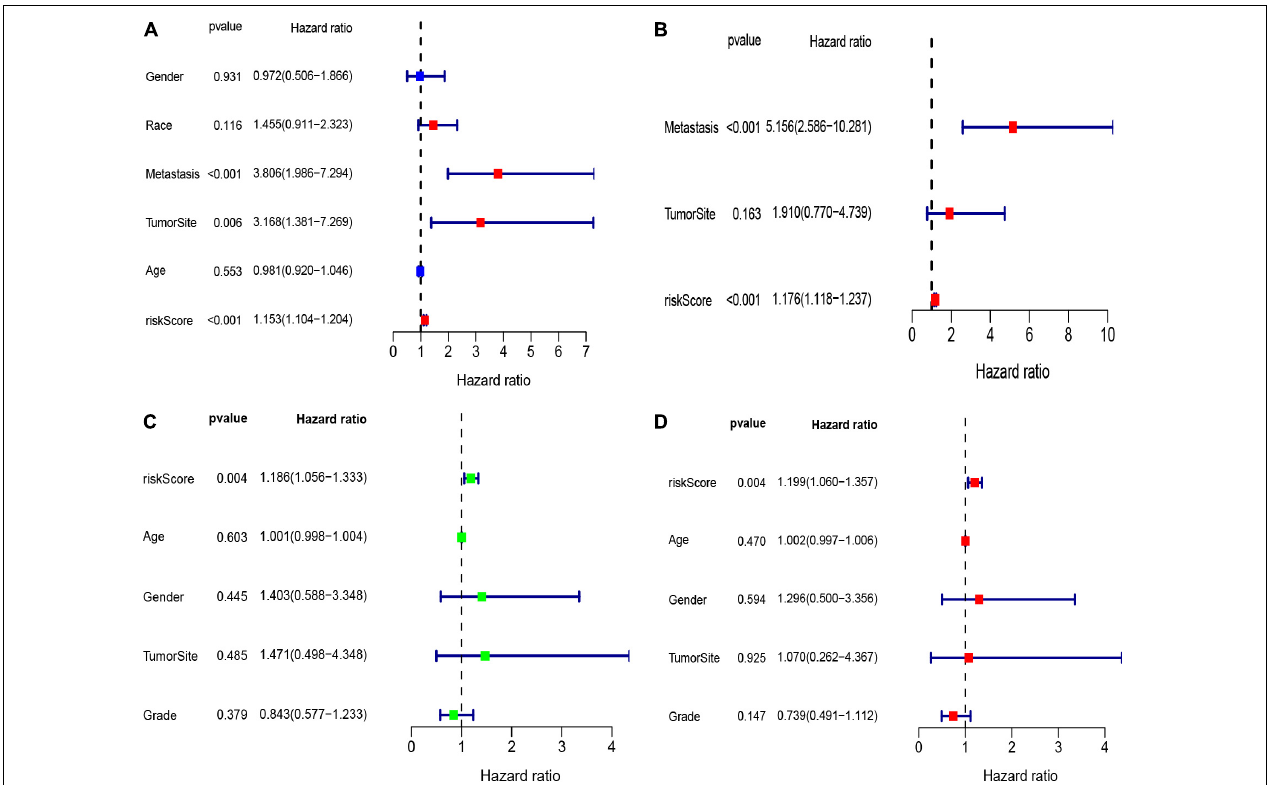
FIGURE 5 | The forest maps of univariate and multivariate Cox regression analysis in the TARGET (A,B) and GEO (C,D) datasets.